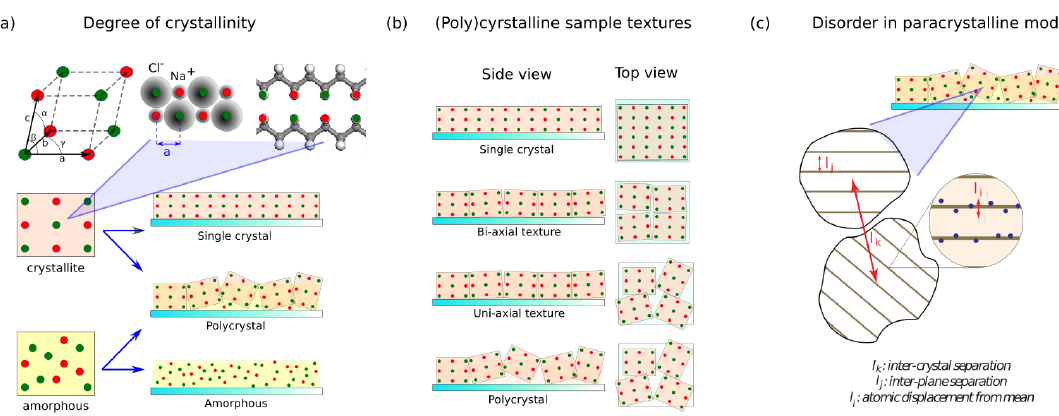
Figure 1. Structural order and disorder. ( a ) Illustration of a periodic atomic placement in a crystallite and lack of thereof in an amorphous material. Note that the reflecting centers can be atoms in an inorganic compound or part of an organic compound. A polycrystalline sample comprises of a mixture of both crystallites and amorphous parts. The more crystallites in a sample, the higher its degree of crystallinity. ( b ) Illustration of sample texture. Texture is the statistical description of crystallite orientations in a sample. A bi-axial texture means crystallites in the sample are aligned on two axes (by symmetry, this necessarily means that they are aligned on the third axis too). By definition, a single crystal sample is bi-axially textured. In contrast, crystallites in a uniaxially textured sample are aligned only on one axis. Lastly, in a sample with no texture, crystallites are oriented randomly in three dimensions. ( c ) Illustration of disorder in the paracrystal model. l i , l j , and l k are the possible atomic displacements from their ideal position in a crystal lattice. Out of these three, only l j and l k